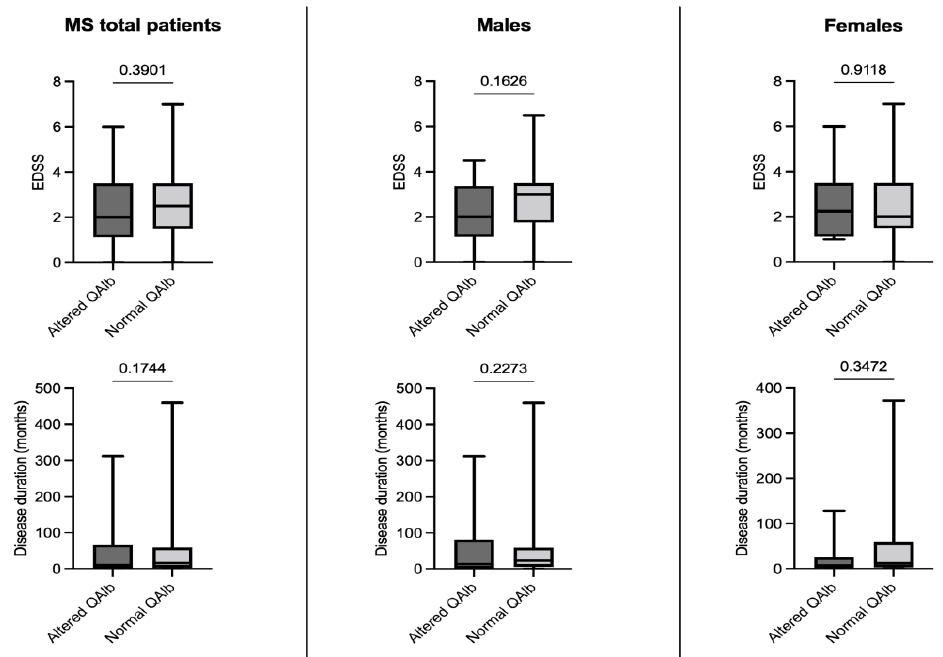
Figure 1. Effect of the blood–cerebrospinal fluid (CSF) barrier permeability evaluated through the albumin quotient (QAlb) on disease severity, expressed with the expanded disability status scale (EDSS), and disease duration in months. Only multiple sclerosis (MS) patients were included (cohort 1 and cohort 2 together). Patients were analyzed as a whole and grouped by sex. Mann–Whitney U test was used for all the comparisons. The boundaries of the boxes represent the 25th–75th quartile. The line within the box indicates the median. The vertical lines above and below the box correspond to the highest and lowest values.